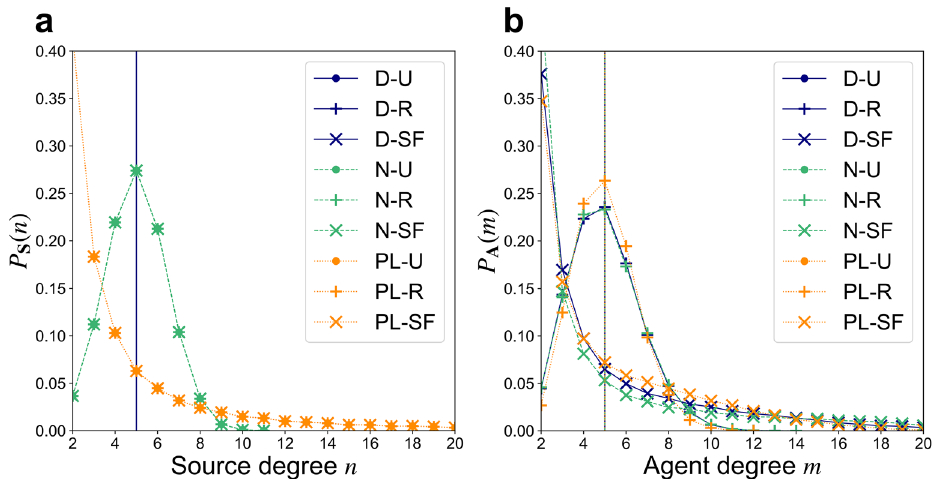
Figure 1. ( a ) CPR source degree distributions, and ( b ) agent degree distributions from 9 network ensembles, each representing a combination of a delta-function (D), normal (N), or power-law (PL) source degree distribution with a uniform (U), random (R), or scale-free-type (SF) agent degree distribution. Source degree distributions are identical for each of the 3 ensembles that share a common source degree distribution type, hence the overlapping